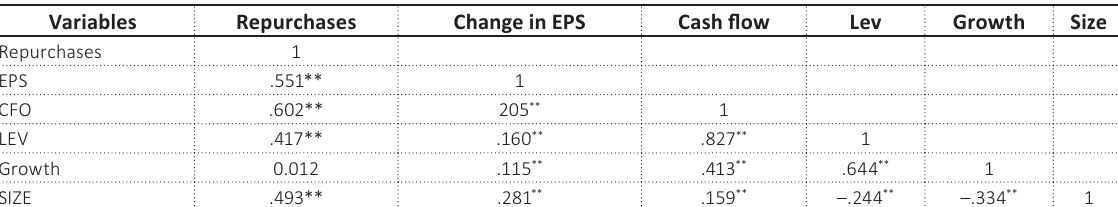
Table 4. Correlation matrix